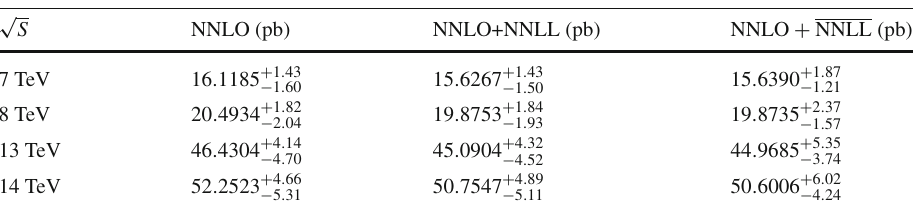
Resummed result at different centre of mass energies at the LHC. The scale uncertainty has been estimated using 7-point scale variation around the central scale